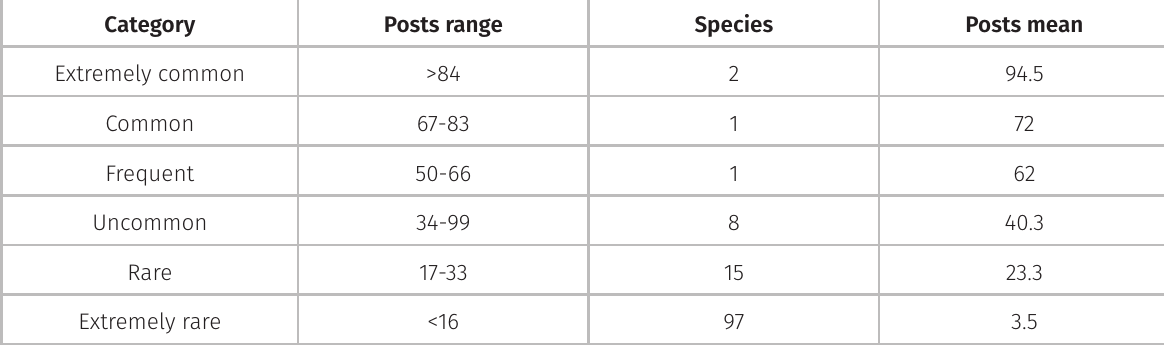
Table II. Ordinal categories according with the frequency of posts retrieved from Facebook groups. Post range: posts interval in which a snake species is allocated. Posts mean: average of posts of the snake species is allocated per posts